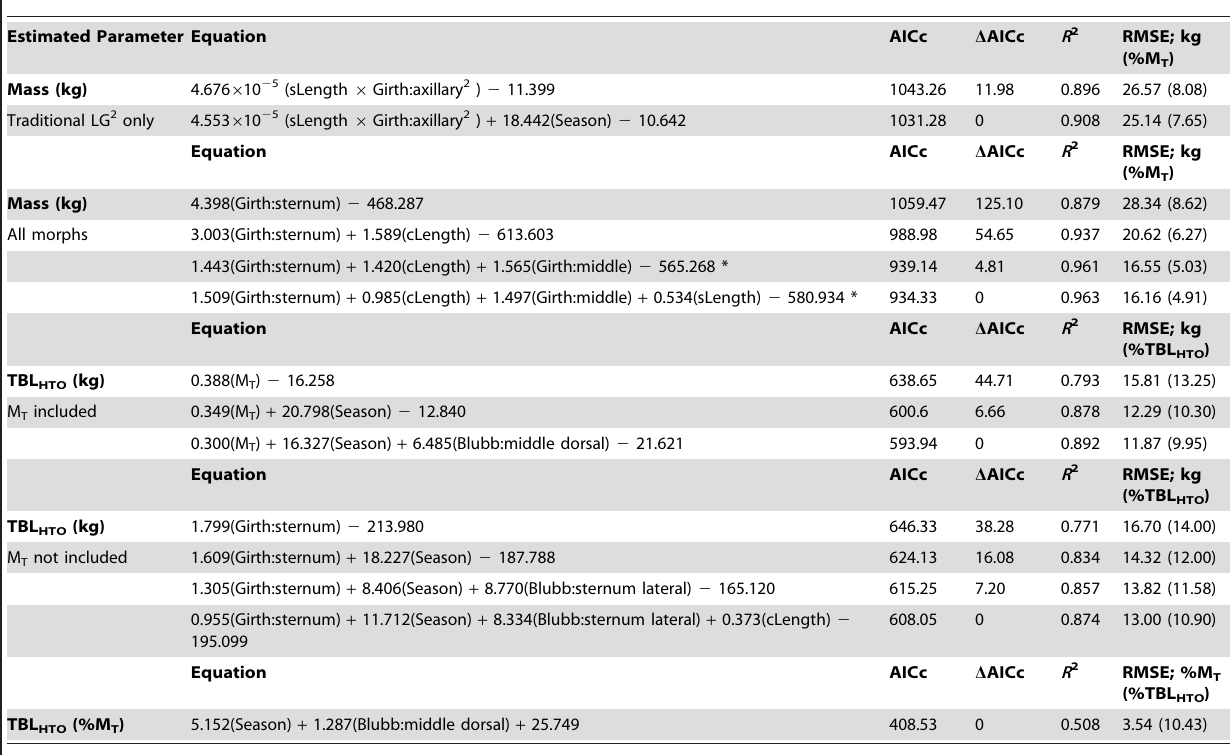
Table 4. Morphometric measurements to estimate body mass and composition.